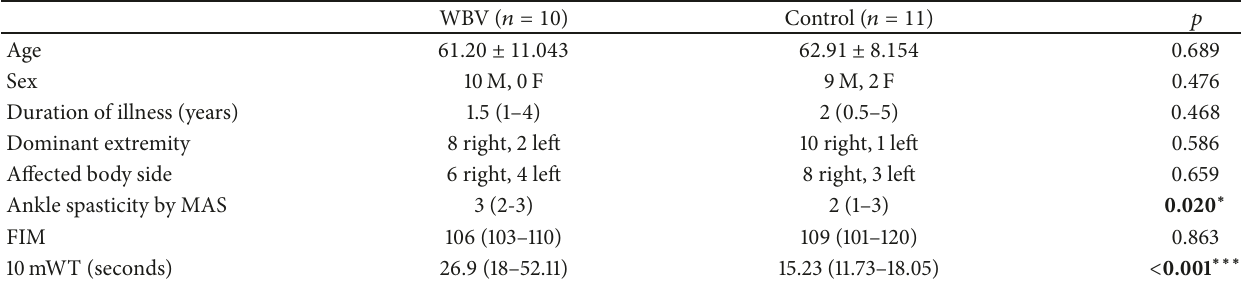
Table 1: Baseline evaluation and demographic characteristics of the patients in comparison.